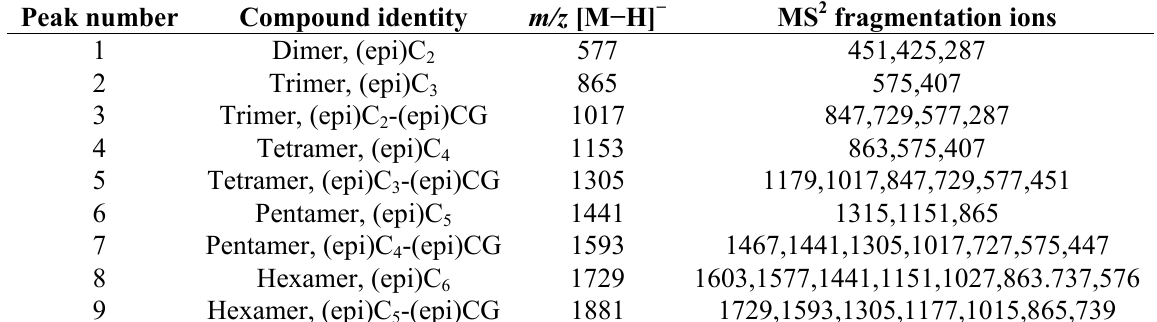
Table 2. Observed ions of proanthocyanidins in P. multiflorum Thunb by ESI-MS (anionic mode). Peak number